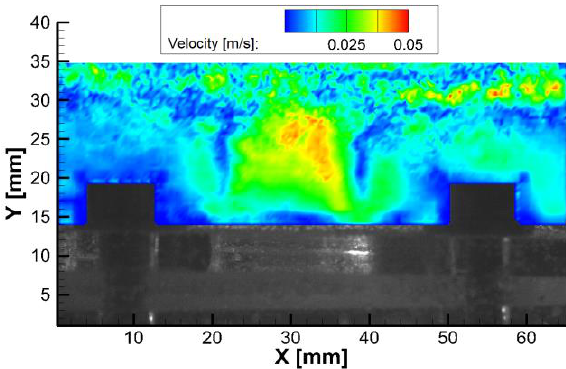
Fig. 3. Scalar map of velocities obtained using the PIV method .